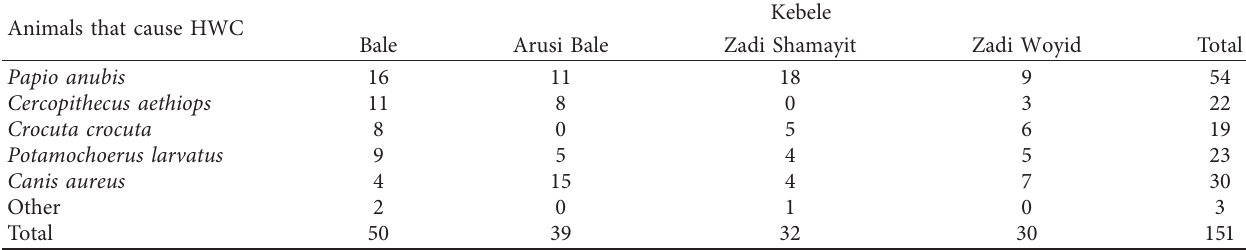
Table 3: Response rate on animals that cause HWC in the study area.